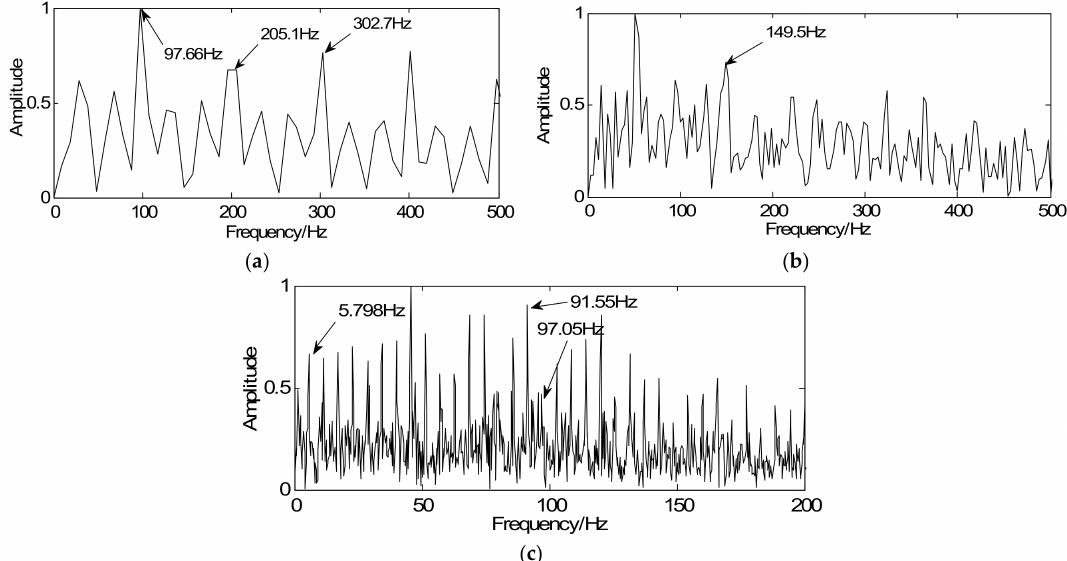
Figure 14. Detection results using the traditional method: ( a ) envelope spectrum of simulated sparse signal, ( b ) envelope spectrum of the inner-race sparse signal, and ( c ) envelope spectrum of the gearbox sparse